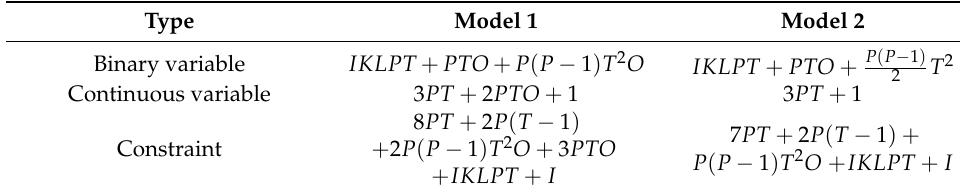
Table 2. The size complexity of each